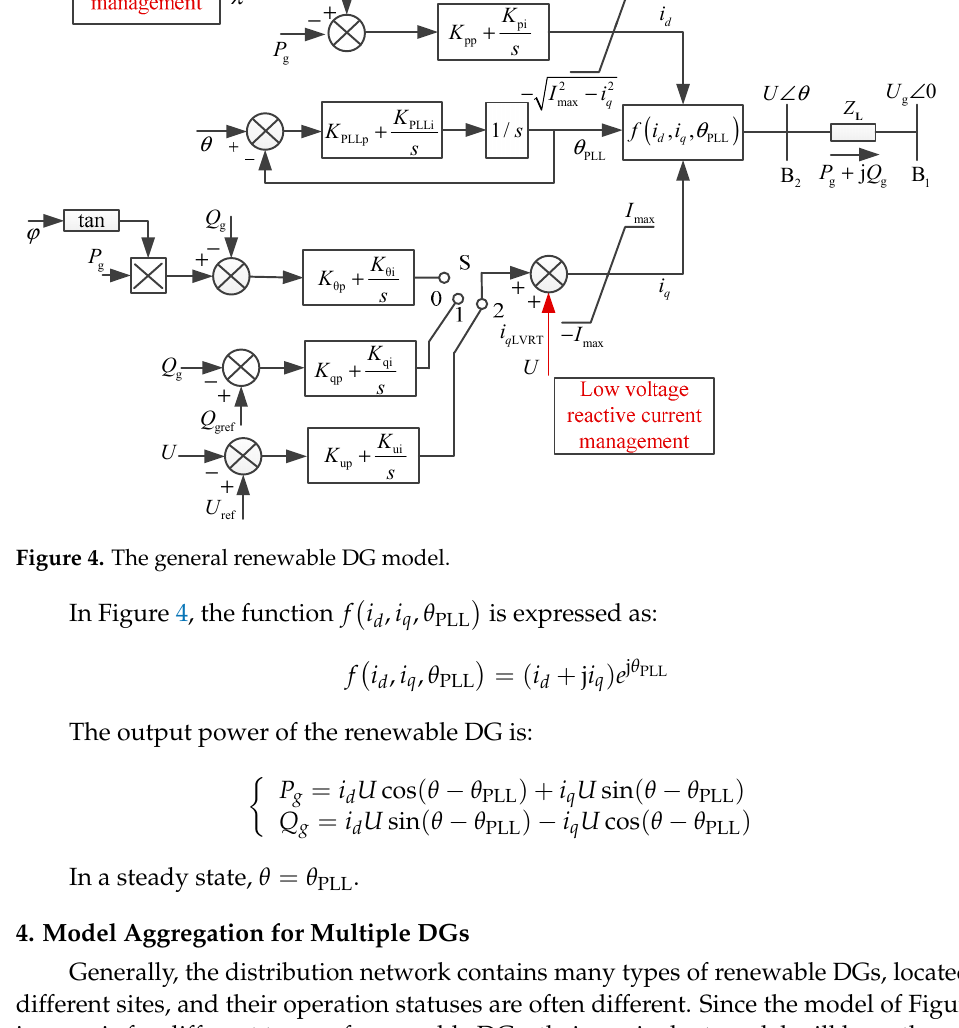
Figure 3. A reduced order model structure for various types of renewable DGs.